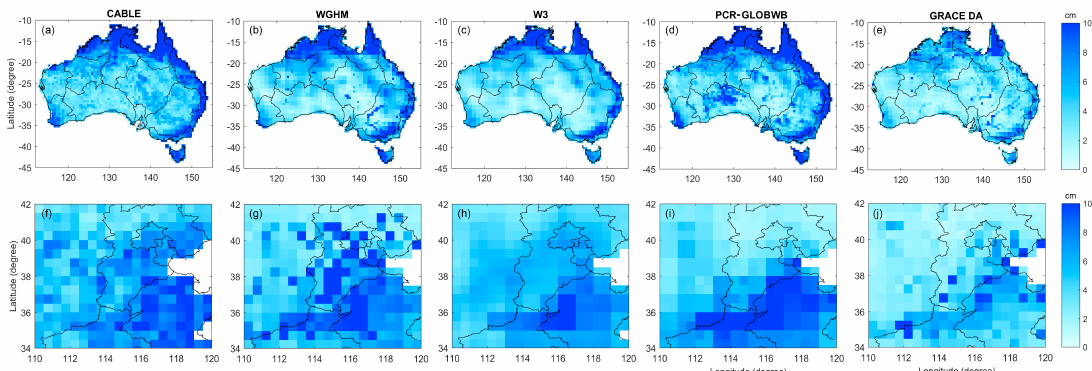
Figure 4. The RMS difference (cm) between the GRACE observation and Δ TWS estimates from four models (CABLE ( a , f ), WGHM ( b , g ), W3 ( c , h ), PCR-GLOBWB ( d , i )) and GRACE DA ( e , j ) in Australia (top row) and NCP (bottom row).